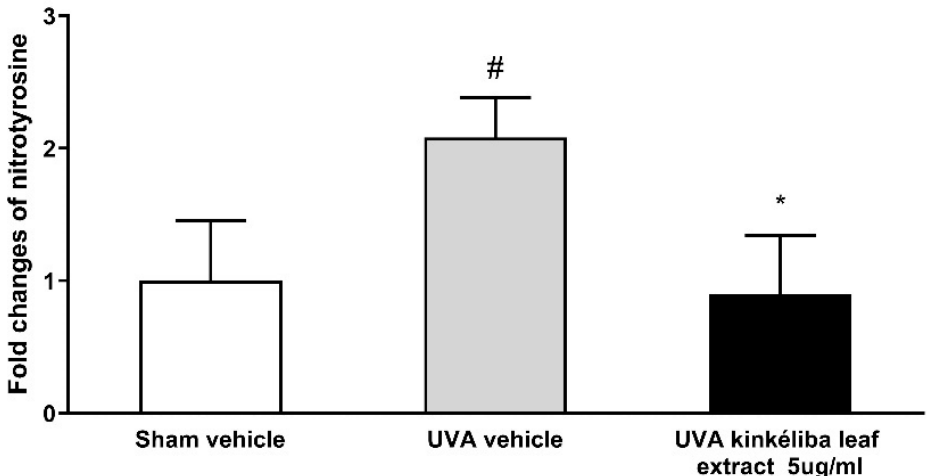
Figure 4. Treatment reduced UVA-induced nitrotyrosine. Cells were treated with kinkéliba leaf extract and cultured for 16 h after UVA irradiation. The formation of nitrotyrosine was evaluated by means of ELISA. Each value is presented as the mean ± SD from triplicate independent experiments.